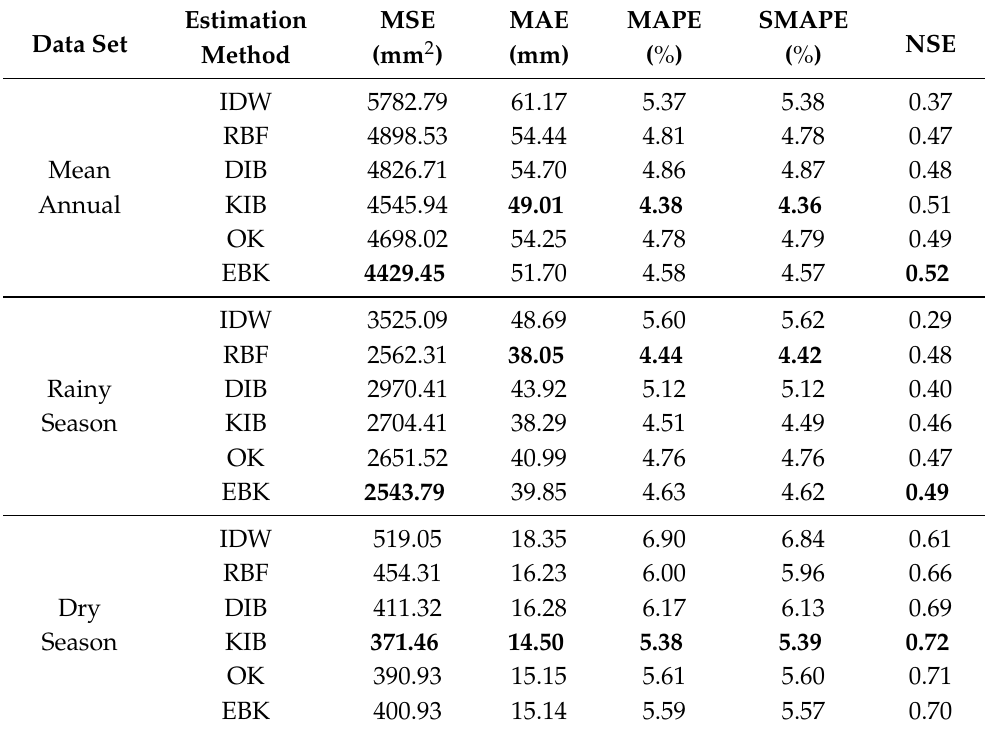
Table 1. Assessment of interpolation models based on cross-validation error and accuracy measures under different climatic conditions. Optimal values of each assessment indicator are shown in